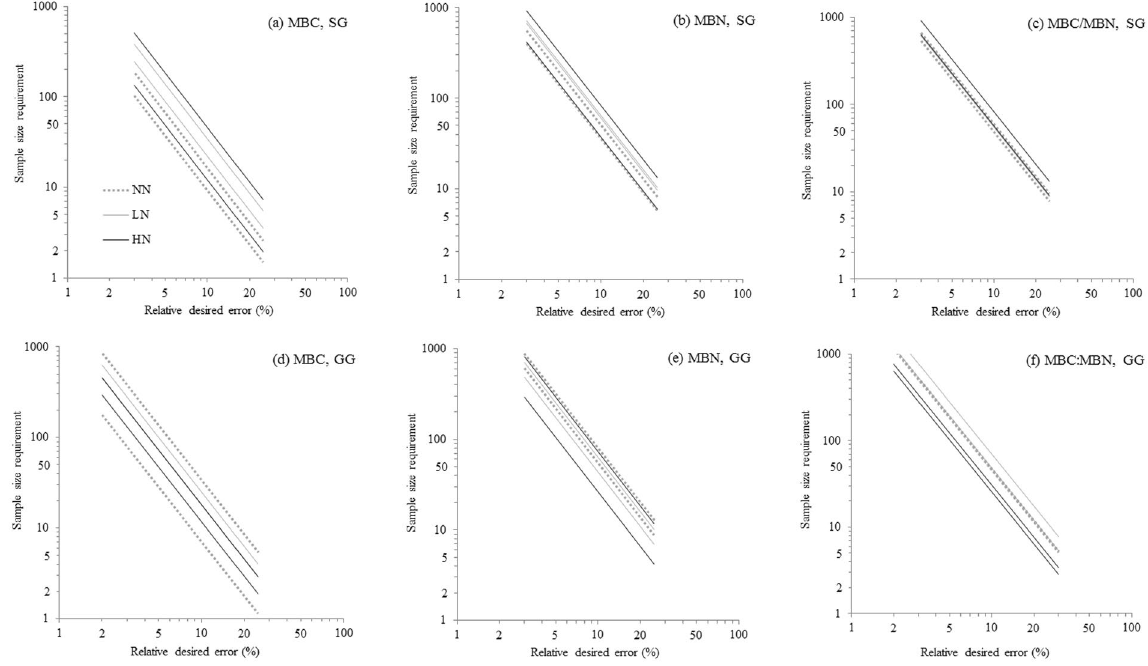
Figure 4. The relationship between log transformed sample size requirements and desired relative errors. Panels a~f denote the linear regression lines for soil MBC, MBN concentrations and MBC:MBN under three N fertilization treatments (i.e. NN, LN and HN) in SG and GG cropland soils in a three-year long fertilization experimental site at the Tennessee State University (TSU) Agricultural Research Center in Nashville, TN, USA. The log scale was applied on both axes. The abbreviations are referred to Table